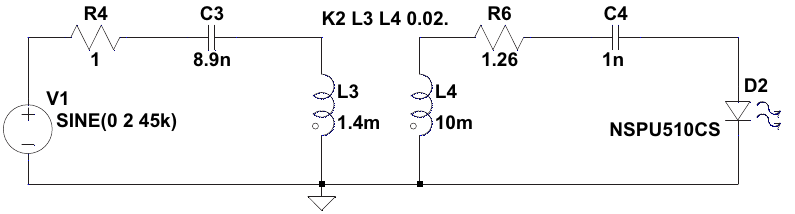
Figure 3. Lumped network of the receiver in parallel connection as proposed in [29].